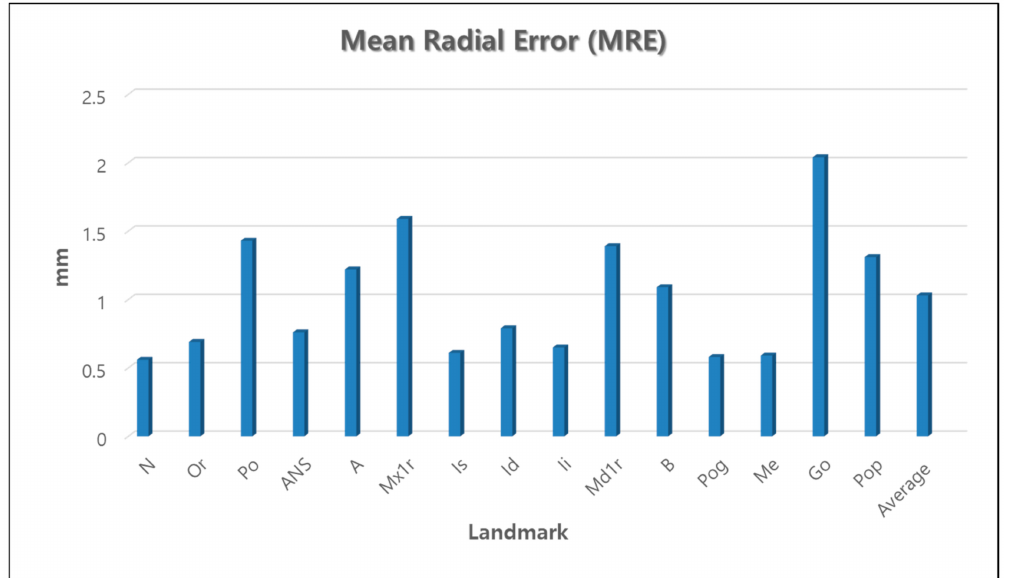
Figure 4. Mean Radial Error of each landmark and average MRE. The paired t -test showed that there were no significant differences between truth ground and AI prediction on CBCT-LC. No significant differences were observed between the truth ground and AI prediction on MIP-LC. The details are described in Tables 3 and 4. Table 3. Comparison of landmark identification between truth ground and AI prediction on the CBCT synthesized lateral cephalograms (CBCT-LC). Truth Ground AI Prediction CBCT-LC